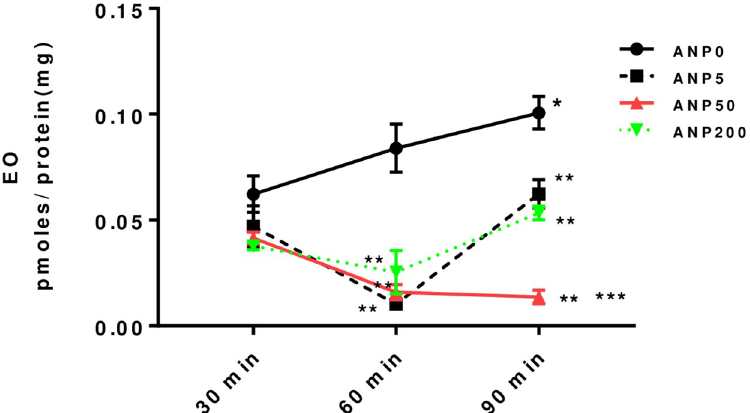
Fig 3. EO content in culture media. The EO content in the culture media of H295R human adrenocortical cells increased significantly at 90 min. in the absence of ANP treatment. ANP concentrations of 5, 50, 200 pg/mL reduced EO secretion at 60 and 90 min. The inhibitory effect of 50 pg/mL ANP was significantly lower compared to lower (ANP5) and higher (ANP200) at 90 min. Error bars represent standard error. ( � P < 0.05, compared to 30 min untreated, �� P < 0.05, compared to untreated at corresponding time point, ��� P < 0.05, compared to ANP5 and ANP200 at 90 min. Y axis units are pM/mg protein).